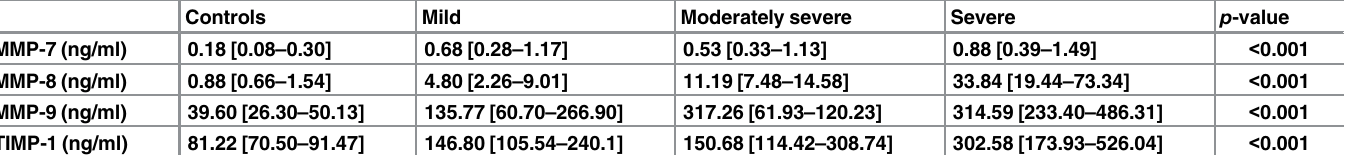
Table 2. Levels of matrix metalloproteinase (MMP) -7,-8,-9 and tissue inhibitor of matrix metalloproteinase-1 (TIMP-1) in acute pancreatitis (AP) patients and controls.